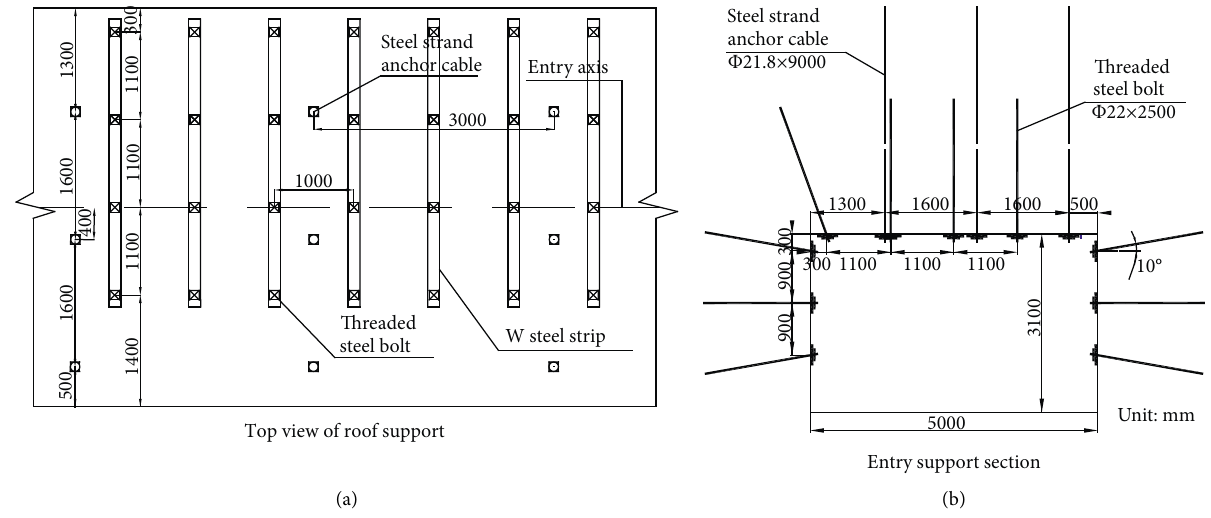
Figure 10: Original design of entry support. (a) Top view of roof support. (b) Entry support